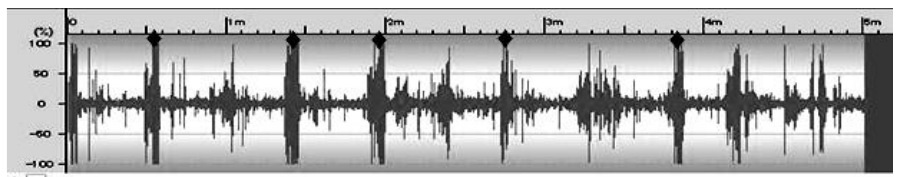
Figure 1. Sound waves of ruminal contractions processed by Sound it! 5.0 for windows (SIT50W, Internet Co., Ltd, Japan). Recording was performed for 5 min from upper left flank of the cow using stethoscope connected sound recorder (ICR-S340RM, Sanyo Electric Co., Ltd, Japan). Closed symbols (♦) indicate the time regions/ places in which ruminal contractions